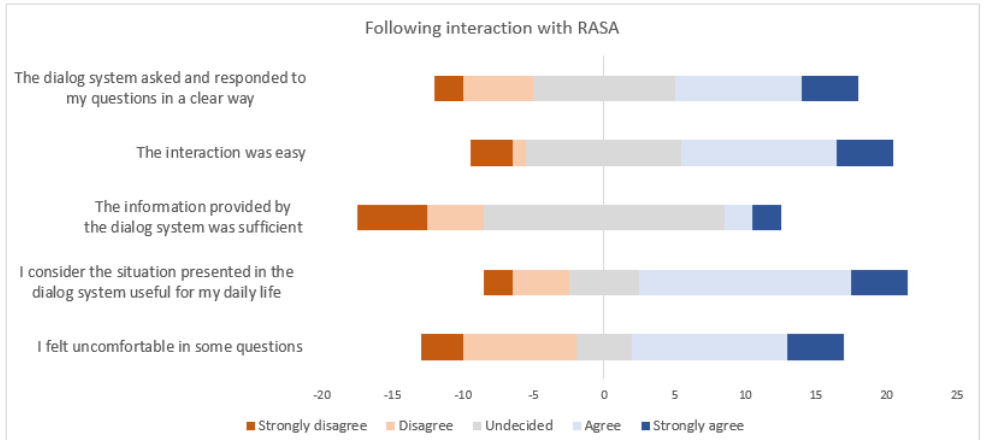
Figure 11. User responses to the questionnaire following interactions with the Rasa dialogue